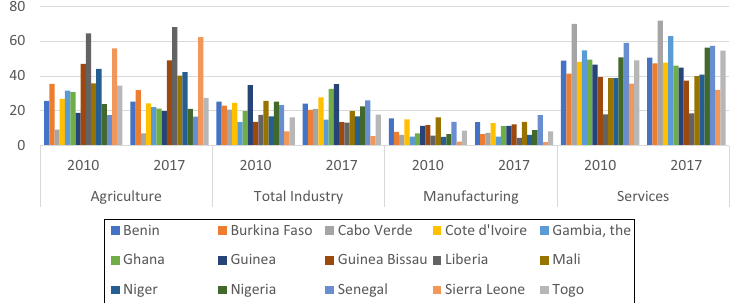
Table 2. Structure of GDP and gross value added (at current market prices) share of GDP (%)